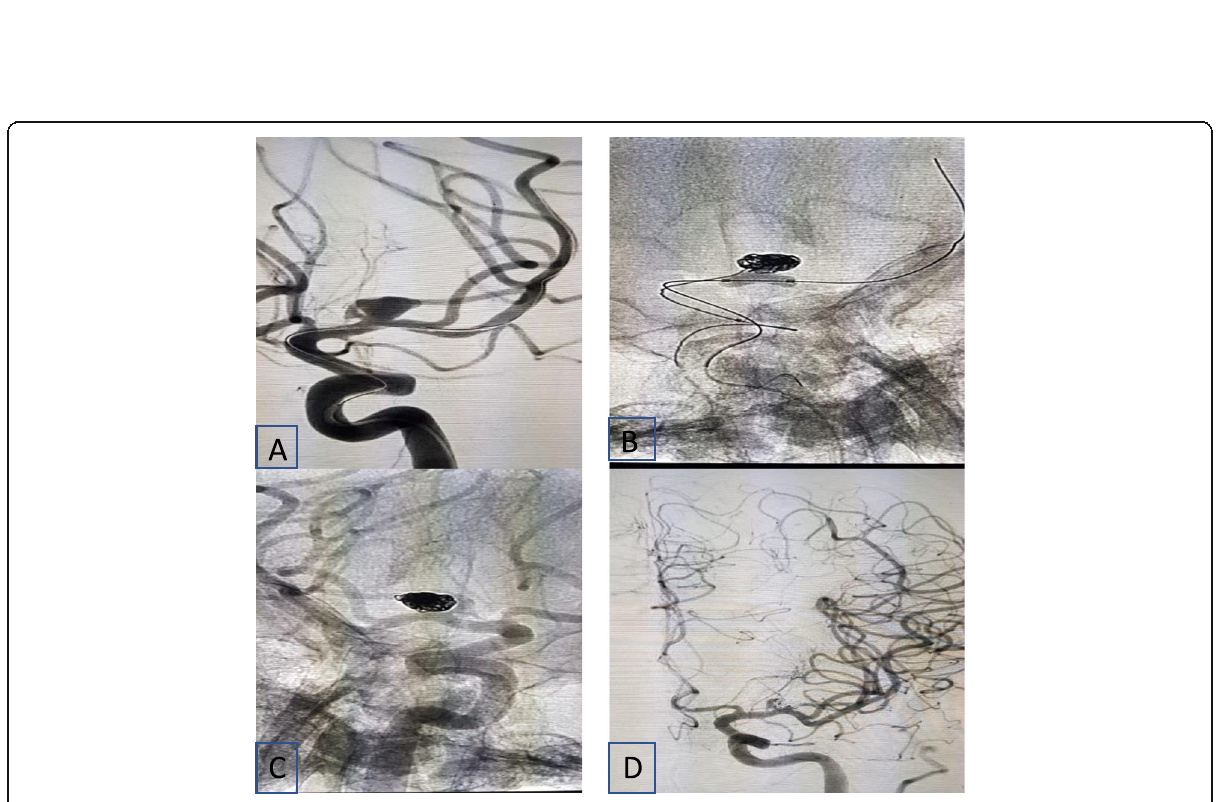
Fig. 4 Balloon-assisted coiling of wide neck M1 aneurysm with temporal branch arising from the neck of the aneurysm. A A-P view with the balloon. B Inflated balloon during coil deployment. C Control angiogram after coiling. D Follow-up showing stable occlusion, no